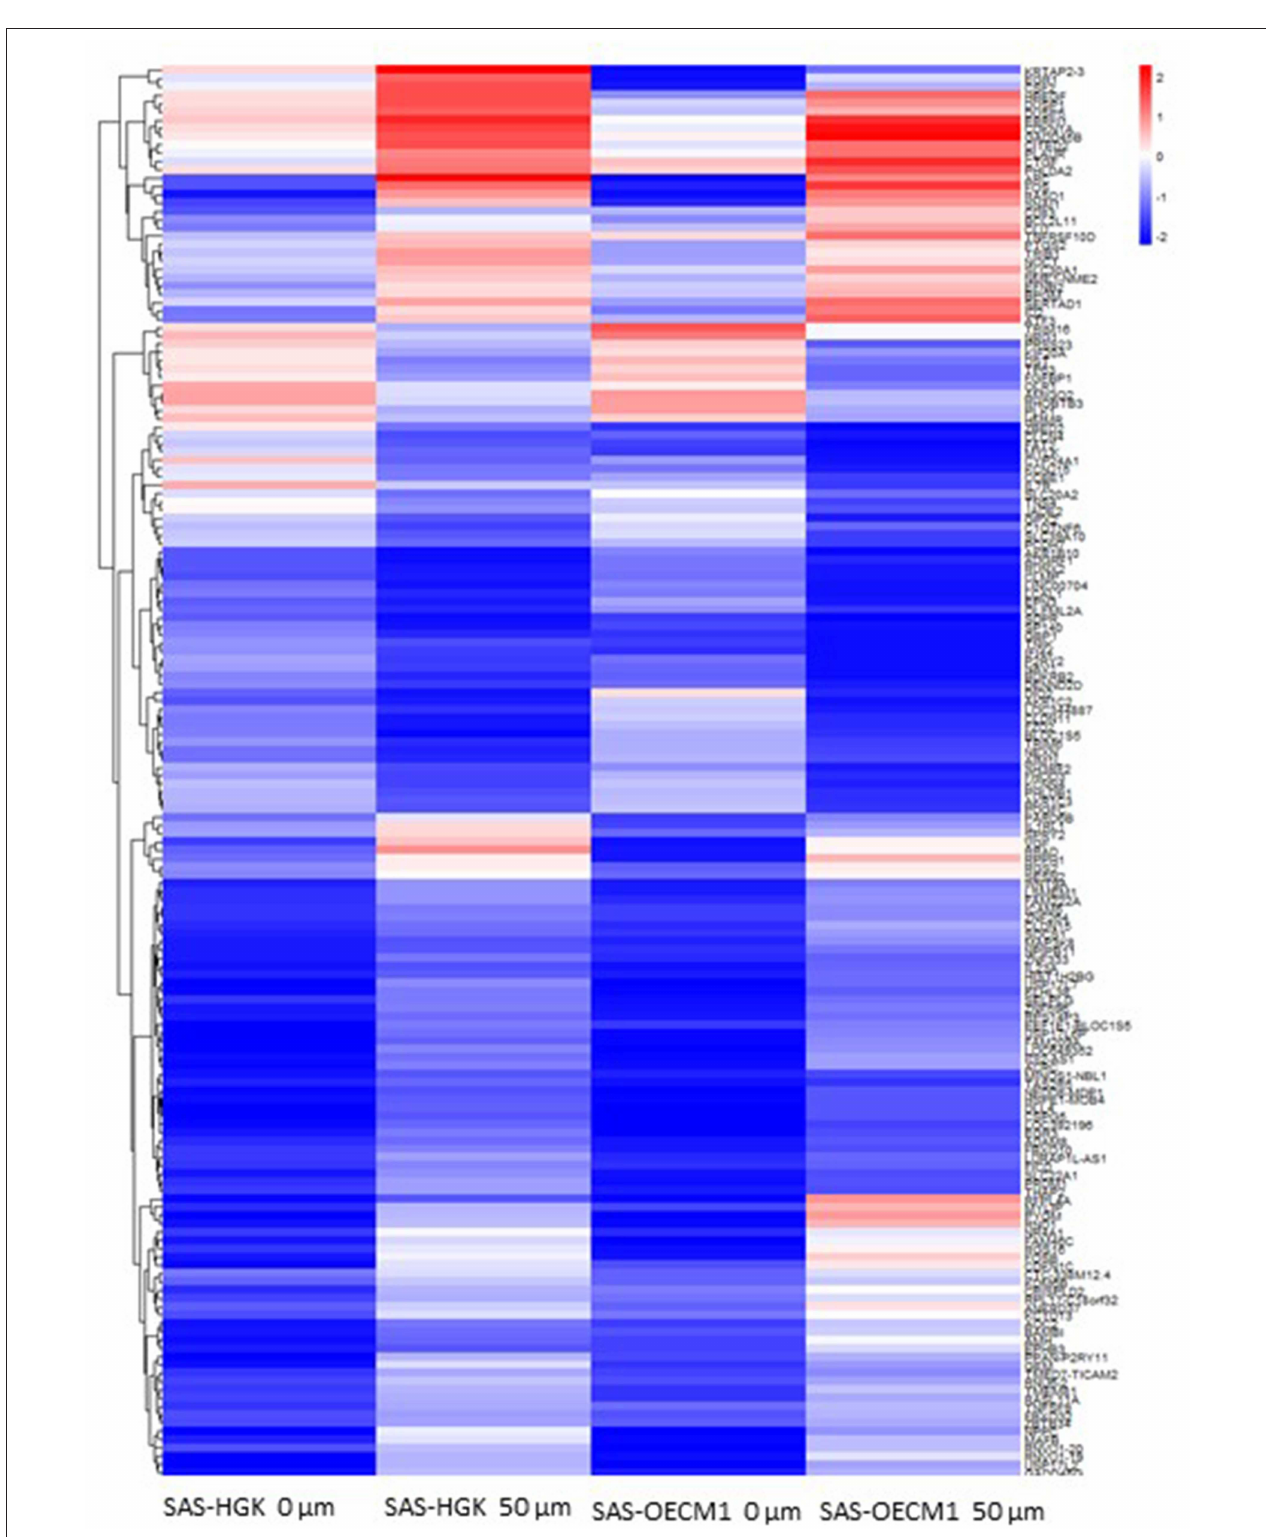
FIGURE 2 | Heatmap showing differential gene expression level with 50 µ M HGK treatment for 24h. Red indicating upregulation, and blue representing downregulation.